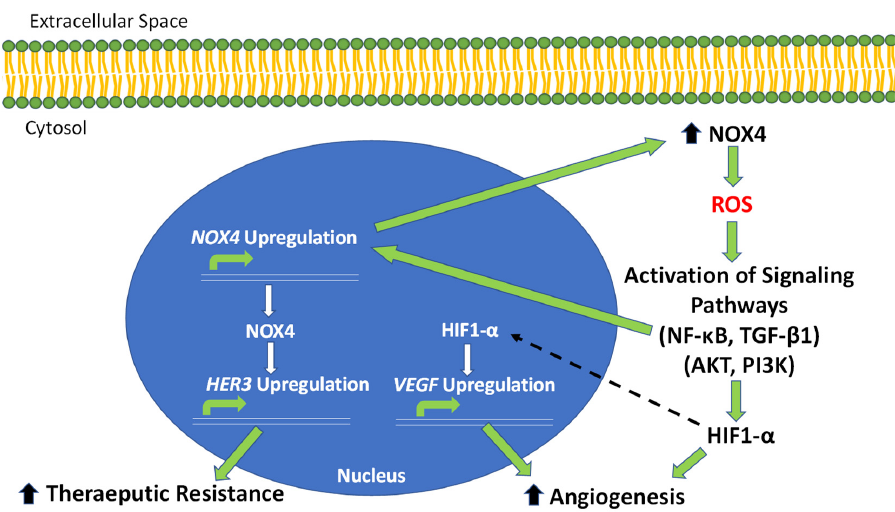
Figure 2. NOX4-driven pathways of OC tumor progression, angiogenesis and therapeutic resistance. The overexpression of NOX4 in OC results in an increase in intracellular ROS production. Increased ROS leads to an increase in HIF1-A through activating PI3K and AKT signaling. HIF1- α then activates the critical angiogenic factor, VEGF. Increased ROS also activates NF- κ B and TGF- β 1 signaling, which lead to the direct upregulation of NOX4. The increase in NOX4 contributes, in a positive-feedback manner, to increased ROS production. NOX4 also activates the expression of HER3, contributing to therapeutic resistance in OC tumors.